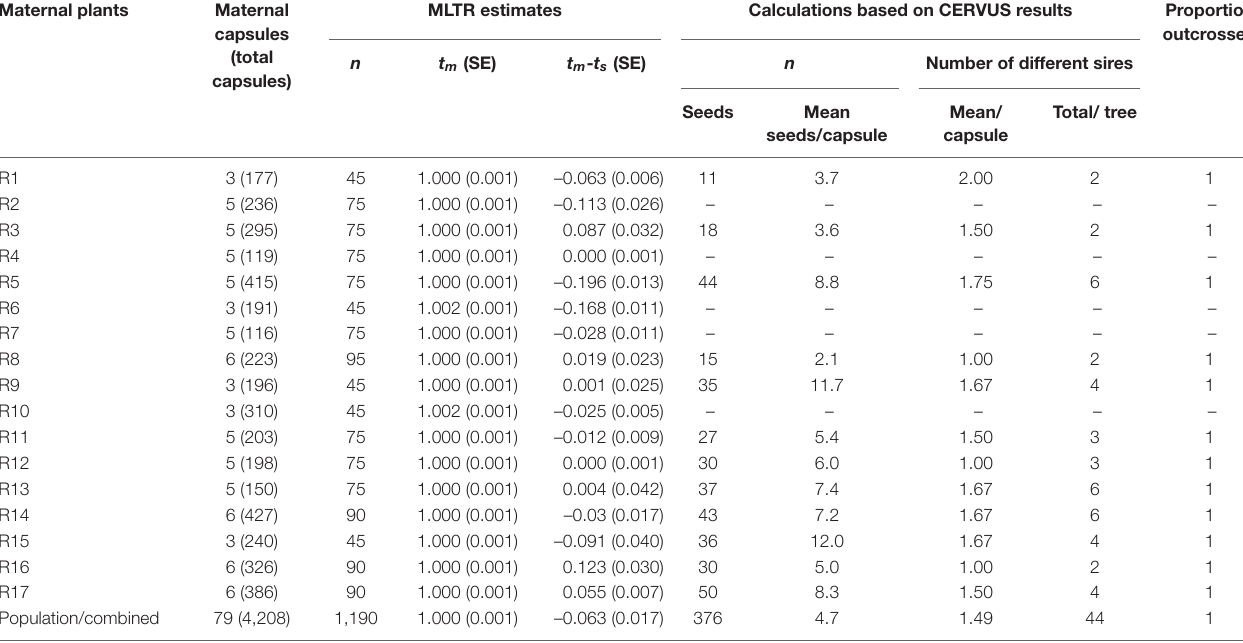
TABLE 3 | Mating system, multiple paternity, and outcrossing rate for 17 open-pollinated trees of Bombax ceiba . Maternal plants Maternal capsules (total capsules)